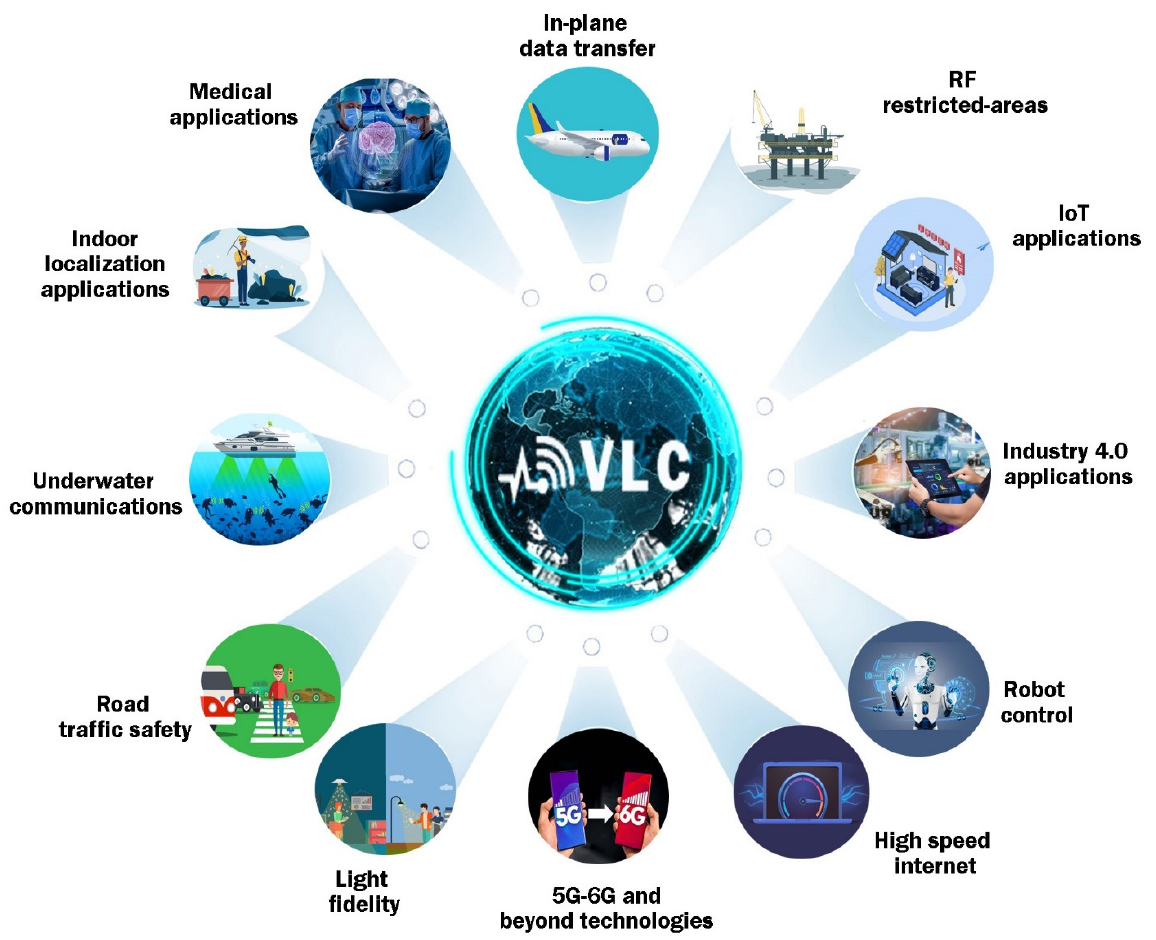
Figure 1. Summary of some of the most representative visible light communications utilization scenarios and applications.